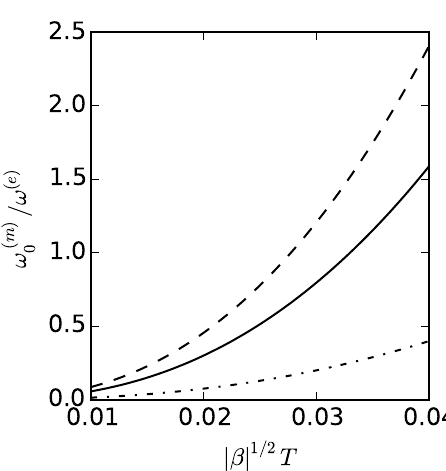
Figure 5. The ratio of the ideal injection trap frequency, ω 0 , to the evaporation trap frequency, ω ( e ) , as a function of | β | 1/2 T . Here we use ω ( e ) = 2 π × 10 − 3 , and plot for temperatures T = 1 (dash-dot), ( e ) becomes greater than one, the gas should be T = 10 (solid), and T = 20 (dash). As the ratio ω 0 / ω compressed before being released into the interferometer. This compression step raises the temperature, but reduces the size of the cloud.